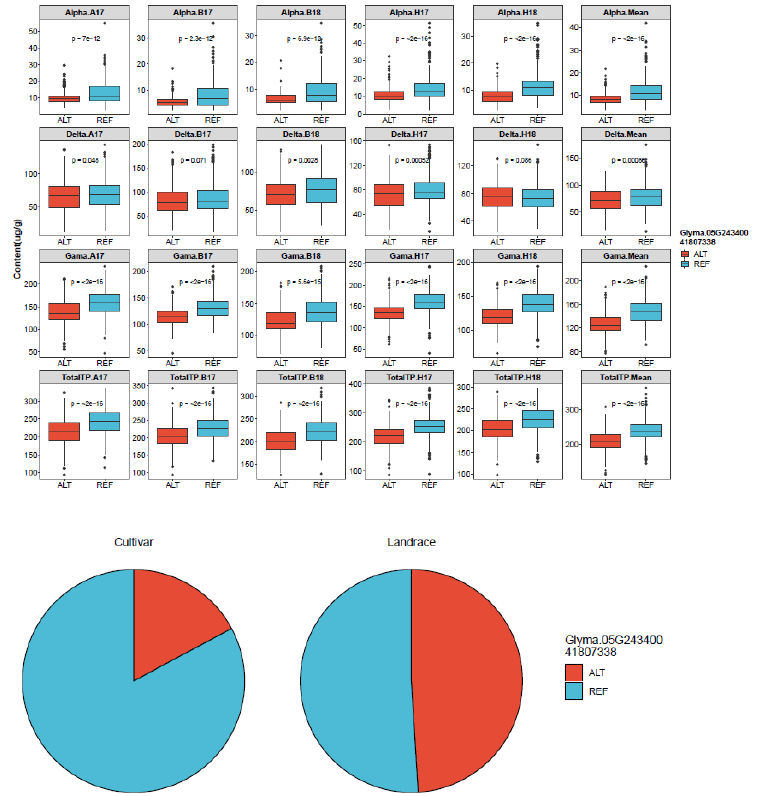
Figure 3. T he protein structure (motifs) variants of Glyma.05G243400 between reference (WT) and mutated proteins using the PredictProtein software: https://predictprotein.org (accessed on 21 June 2022) .